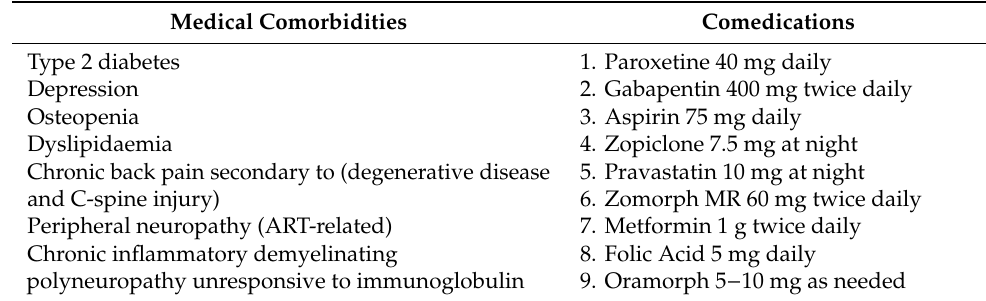
Table 3. Mr X comorbidities and